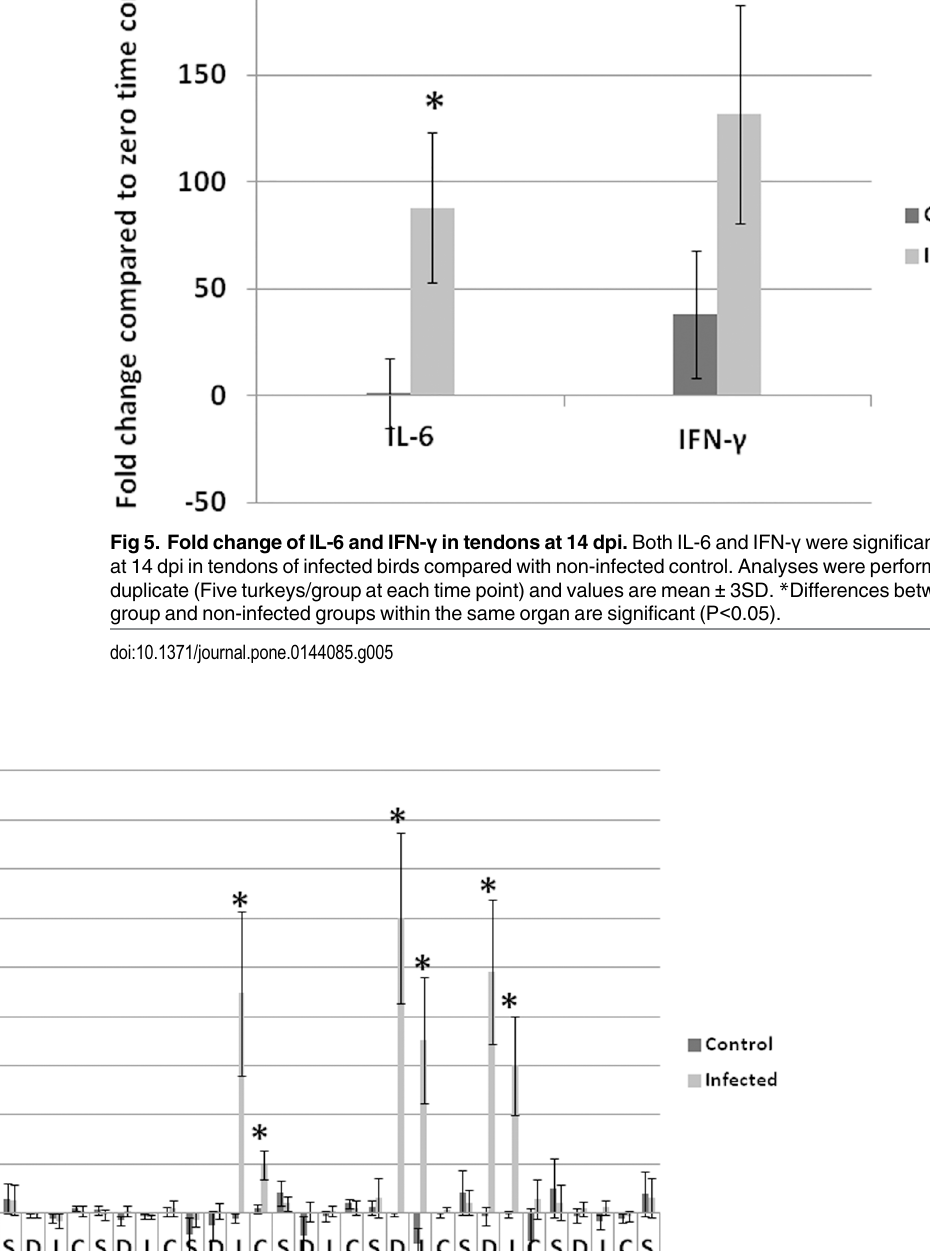
PLOS ONE | DOI:10.1371/journal.pone.0144085 December 11,